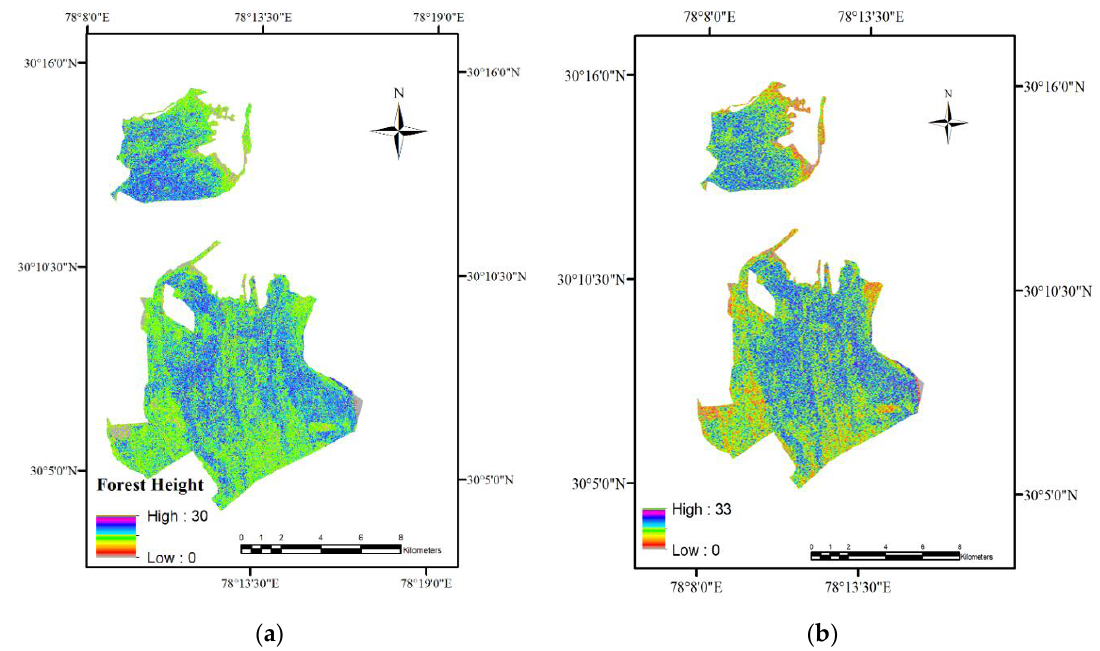
Figure 9. ALOS-2 PALSAR-2 inversion-based forest height for the Barkot and Thano forest ranges using ( a ) the TSI model and ( b ) the CAI model.